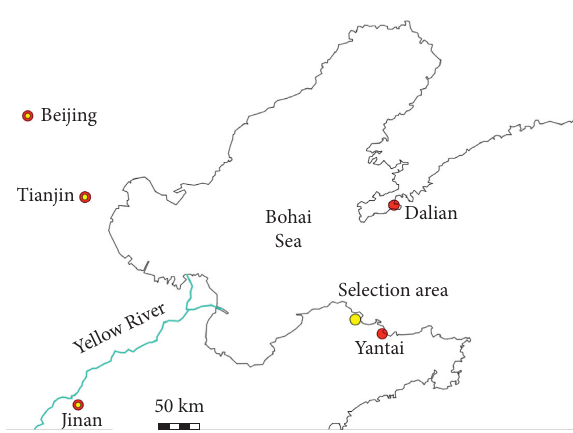
Figure 1: Geographic schematic map of the selected site of the water-sealed storage caverns in the Yantai city of Shandong province in